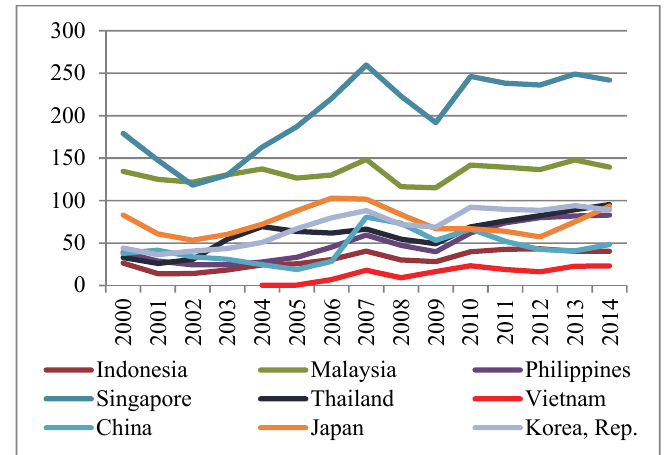
Fig. 5. Stock market capitalisation to GDP (%) Data source: World Bank Database, BIS Debt Securities Statistics